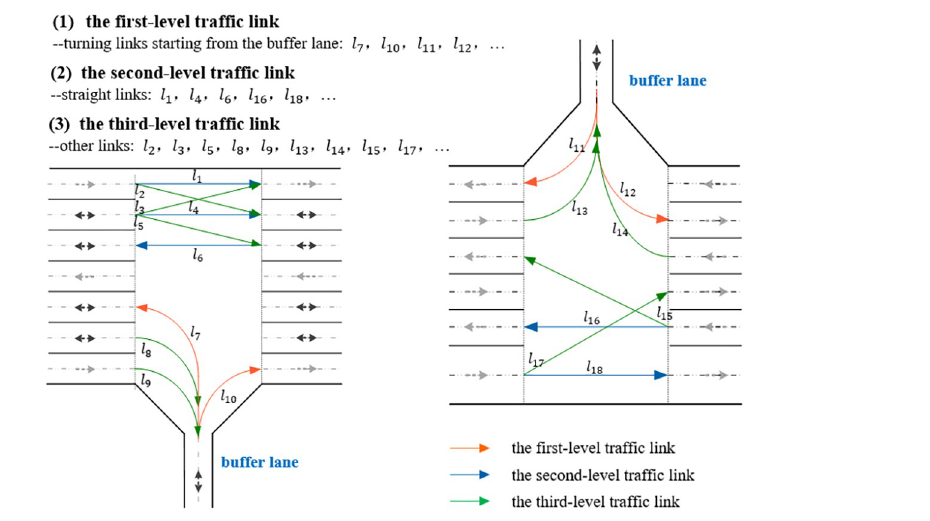
Fig 15. An illustration of the proposed intersection traffic